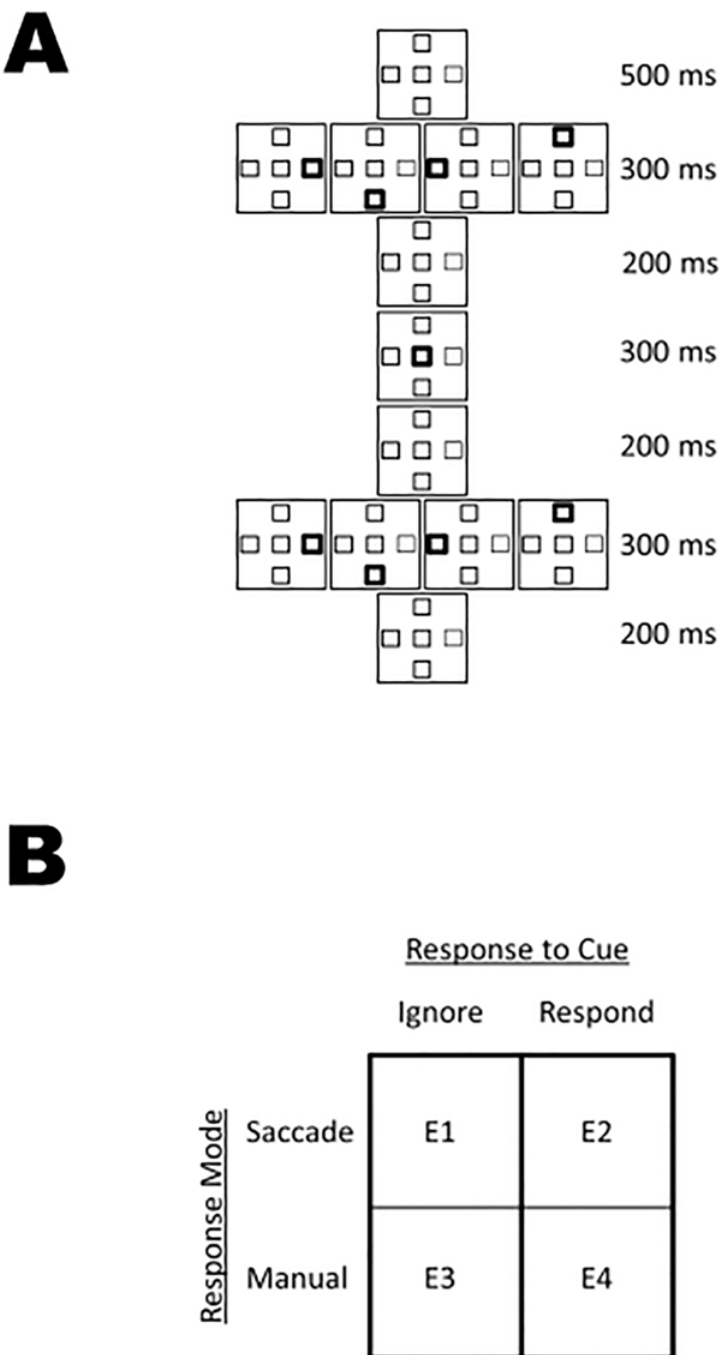
Fig 2. Sequence of events in each experiment (a). See text for explanation. Conditions for Experiments 1 – 4 (b). See text for explanation.